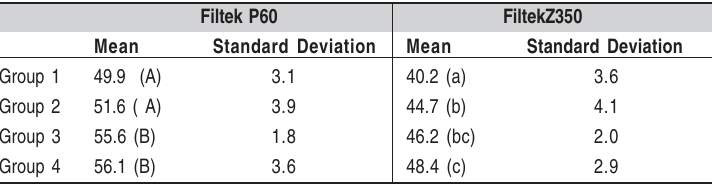
Table 2: Mean and standard deviation of Vickers hardness of experimental groups according to the type of composite